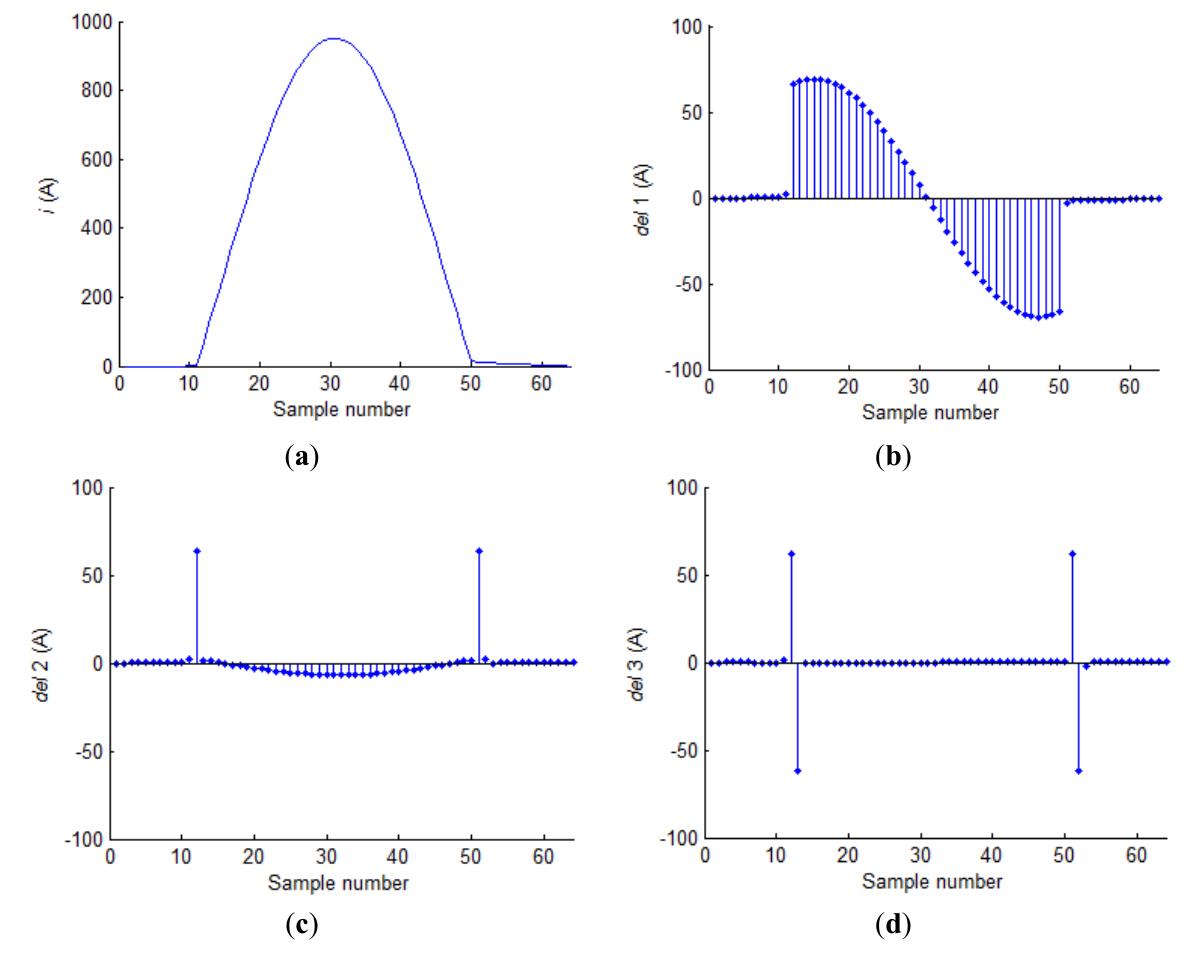
Figure 2. Inrush current and its difference functions: ( a ) inrush current; ( b ) del 1[ n ]; ( c ) del 2[ n ]; and ( d ) del 3[ n